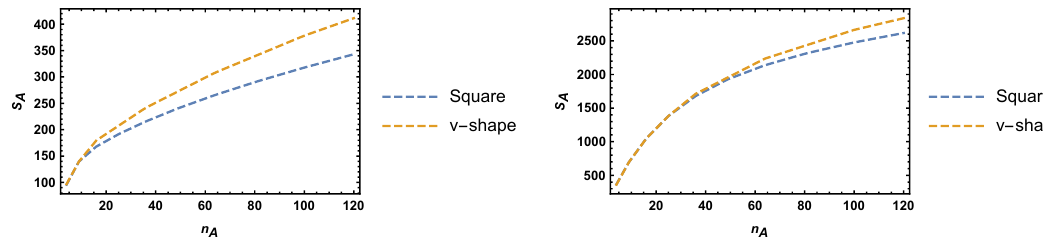
Figure 12 . Entanglement entropy as a function of number of sites enclosed by the entangling region, n A , for square and v-shape. These two shapes have the same volume (see (cid:12)gure 8). In the left panel we have set z = 20 and in the right panel z = 50. For small regions, where we expect a volume law, the entropy for both shapes coincides. As n A increases, the entanglement of the v-shape overtakes the square since it has a larger area. We have set N x = N y = 250 and m = 0 with Dirichlet boundary